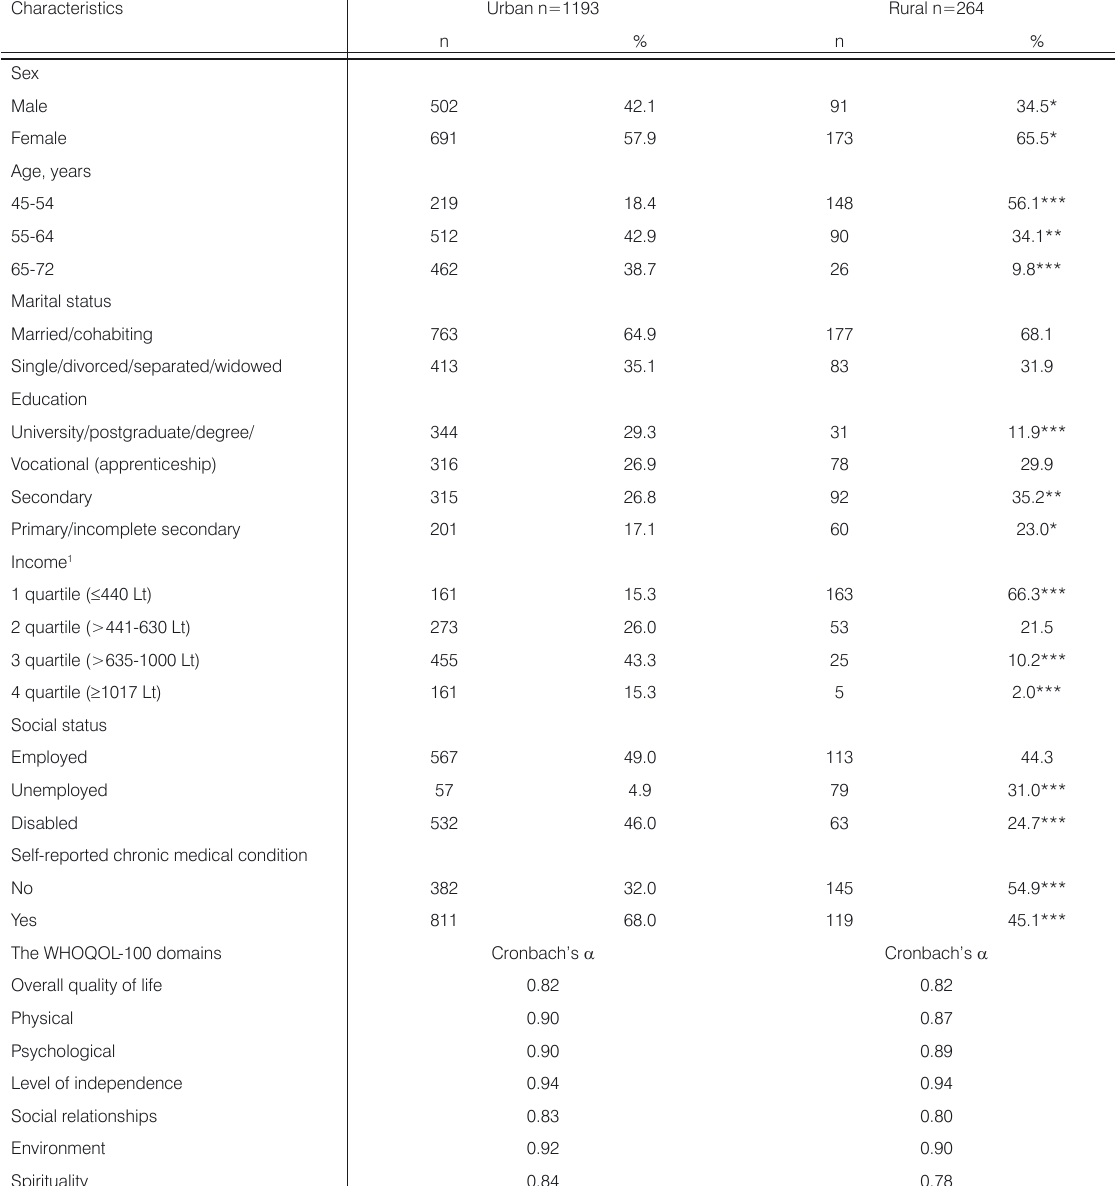
Table 1. Characteristics of urban and rural populations and internal consistency of the